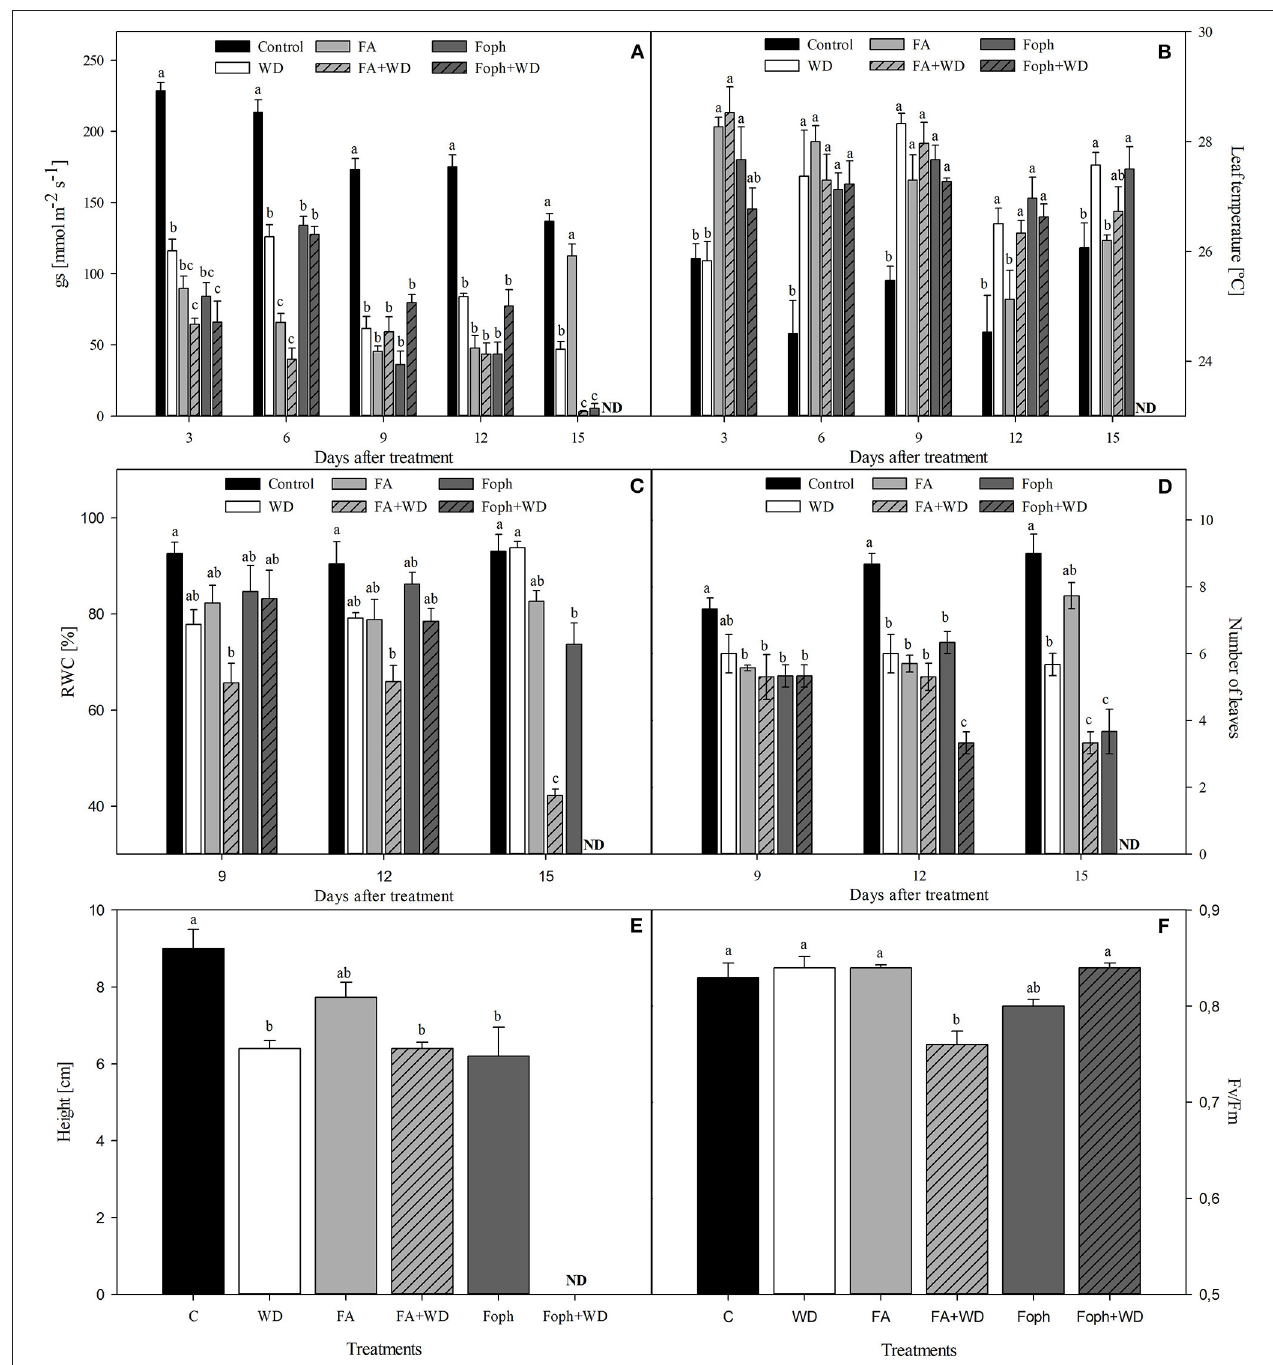
FIGURE 5 | Effect of water deficit (WD), exposure to fusaric acid (FA), and inoculation with F. oxysporum f. sp. physali (Foph) on physiological variables of cape gooseberry plant ecotype Colombia in a hydroponic system. (A) Stomatal conductance, (B) leaf temperature, (C) leaf relative water content (RWC), (D) number of leaves, (E) plant height at 15 DAT, and (F) quantum yield of photosystem II (Fv/Fm) at 6 DAT. Bars represent the standard error. Different letters show significant differences ( P ≤ 0.0 5 ). Chart bars represent the mean of four values ± standard error ( n = 3). Bars followed by different letters indicate statistically significant differences according to the Tukey test ( P ≤ 0.05). ND, not